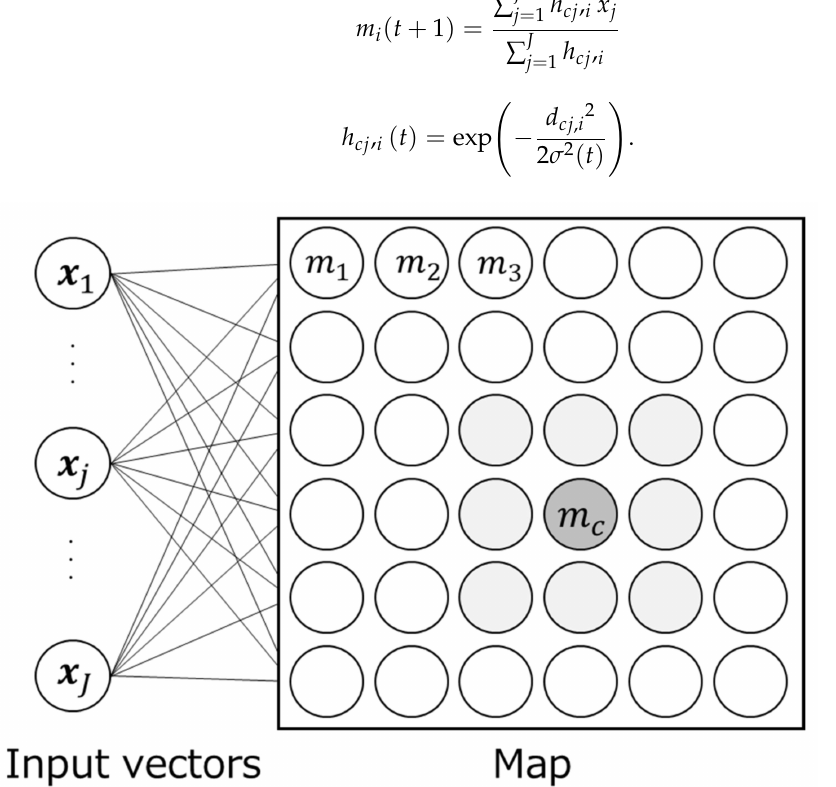
Figure 1. The structure of the